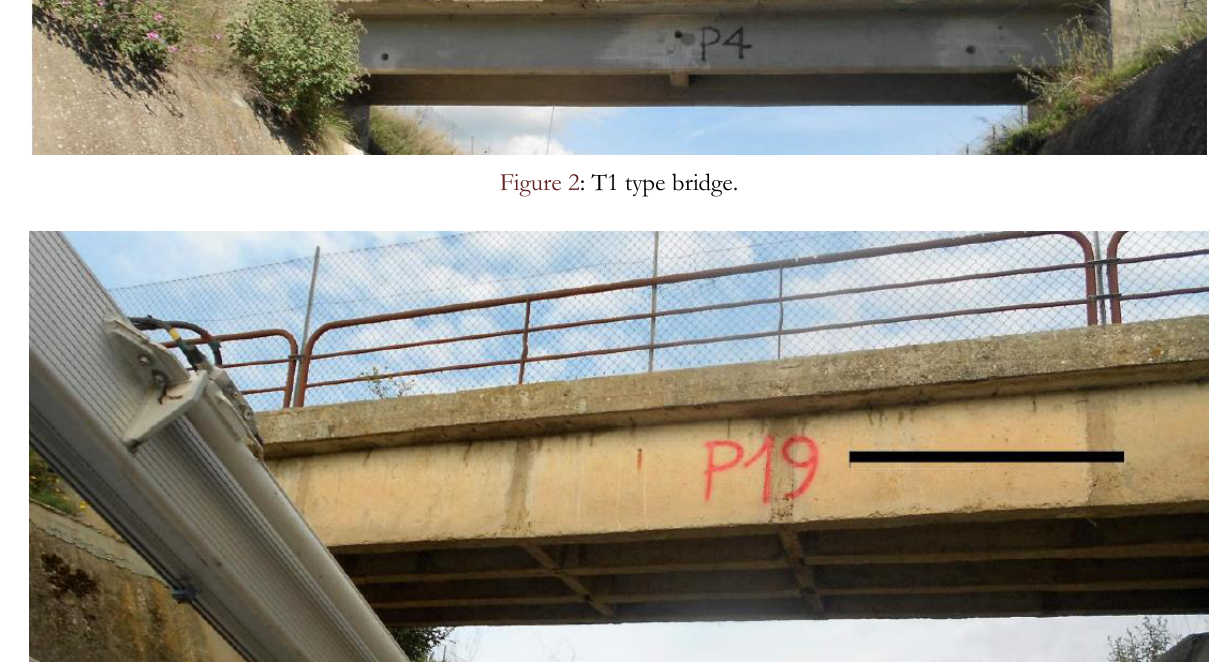
Figure 3: T2 type bridge.